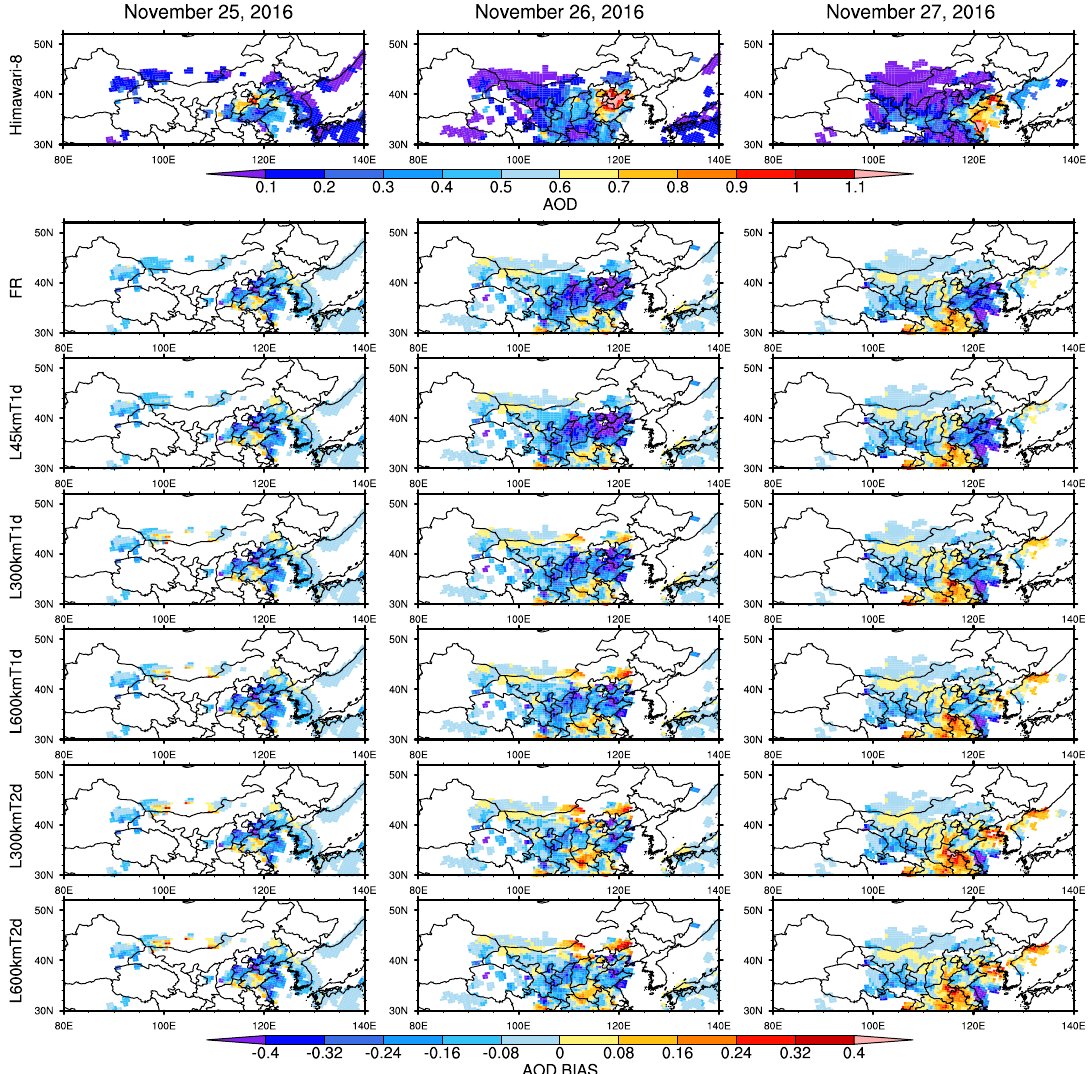
Figure 4. The horizontal distributions of the daily mean Himawari-8 aerosol optical depths (AODs) and the daily mean differences in the simulated AODs minus the Himawari-8 observed AODs for the six experiments.